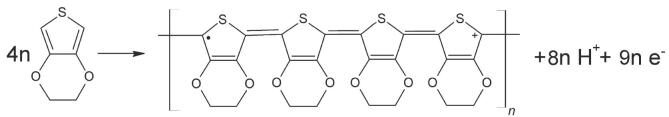
Electrochemical reaction for the electropolymerisation of PEDOT.